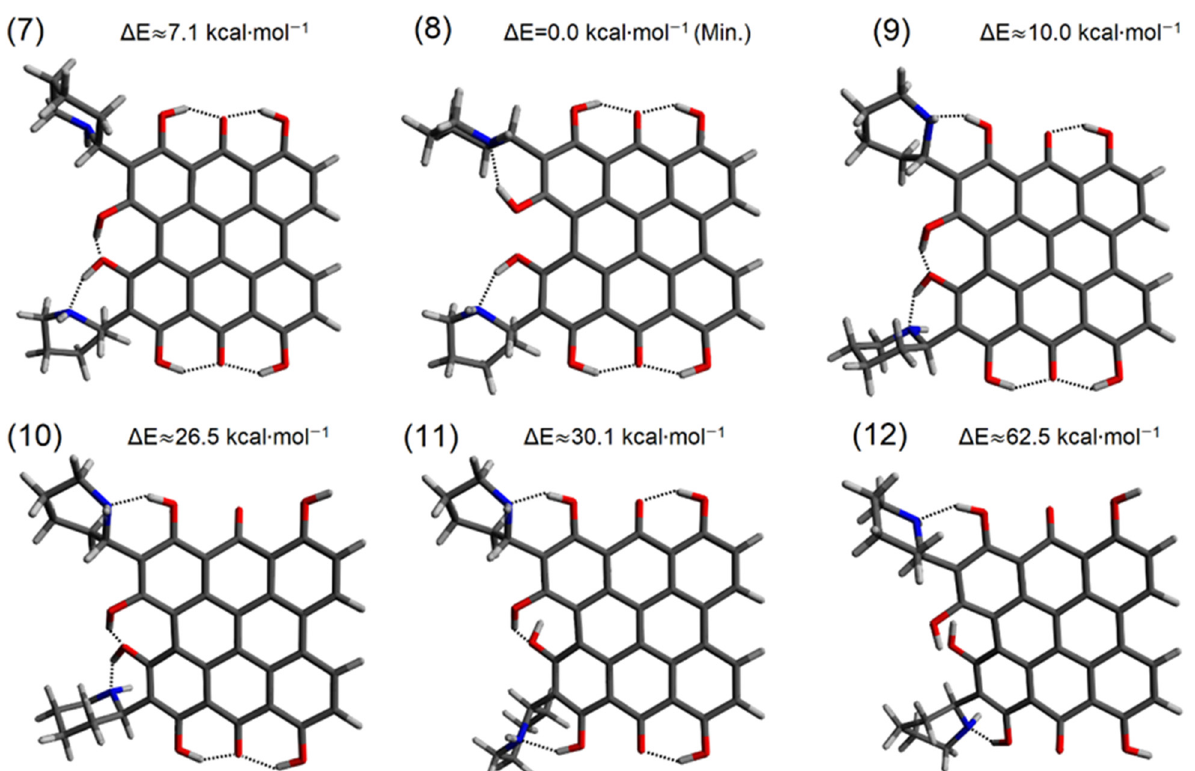
Figure 2. Conformers (7–12) of fagopyrin B.